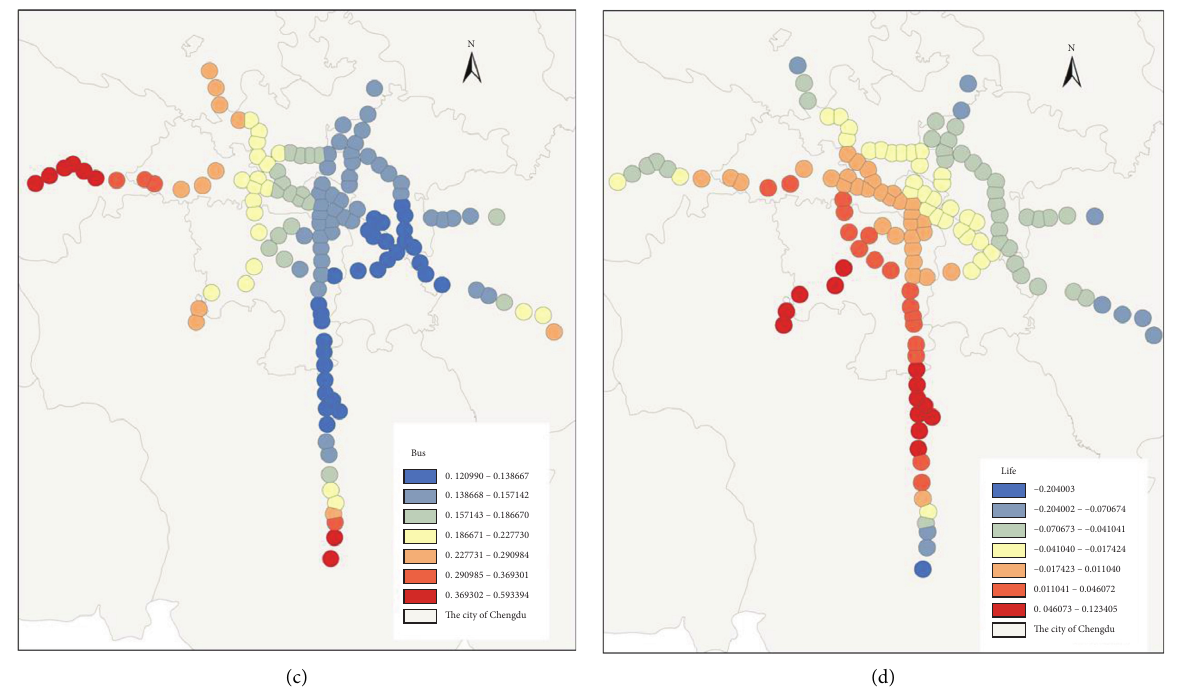
Figure 15: (a–d) Spatial distribution of the coefficients of the four variables of buildings , restaurant , bus , and life in the MGWR model,